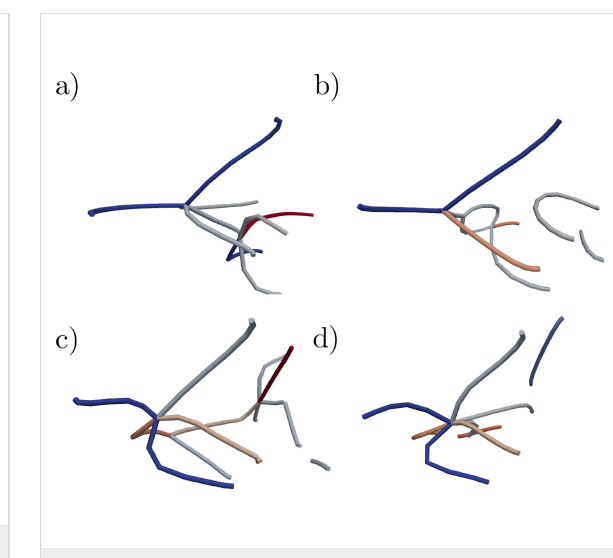
Figure 8: Dislocation interacting to break the dendrite. (a–b) The locking multijunction (see Figure 6) is broken as the <112> partial is disassociated from the junction. (c–d) Partial nucleated at the particle surface (here lower right about the orifice) interacts with the partials in the dendrite pinned to the surface, resulting in a